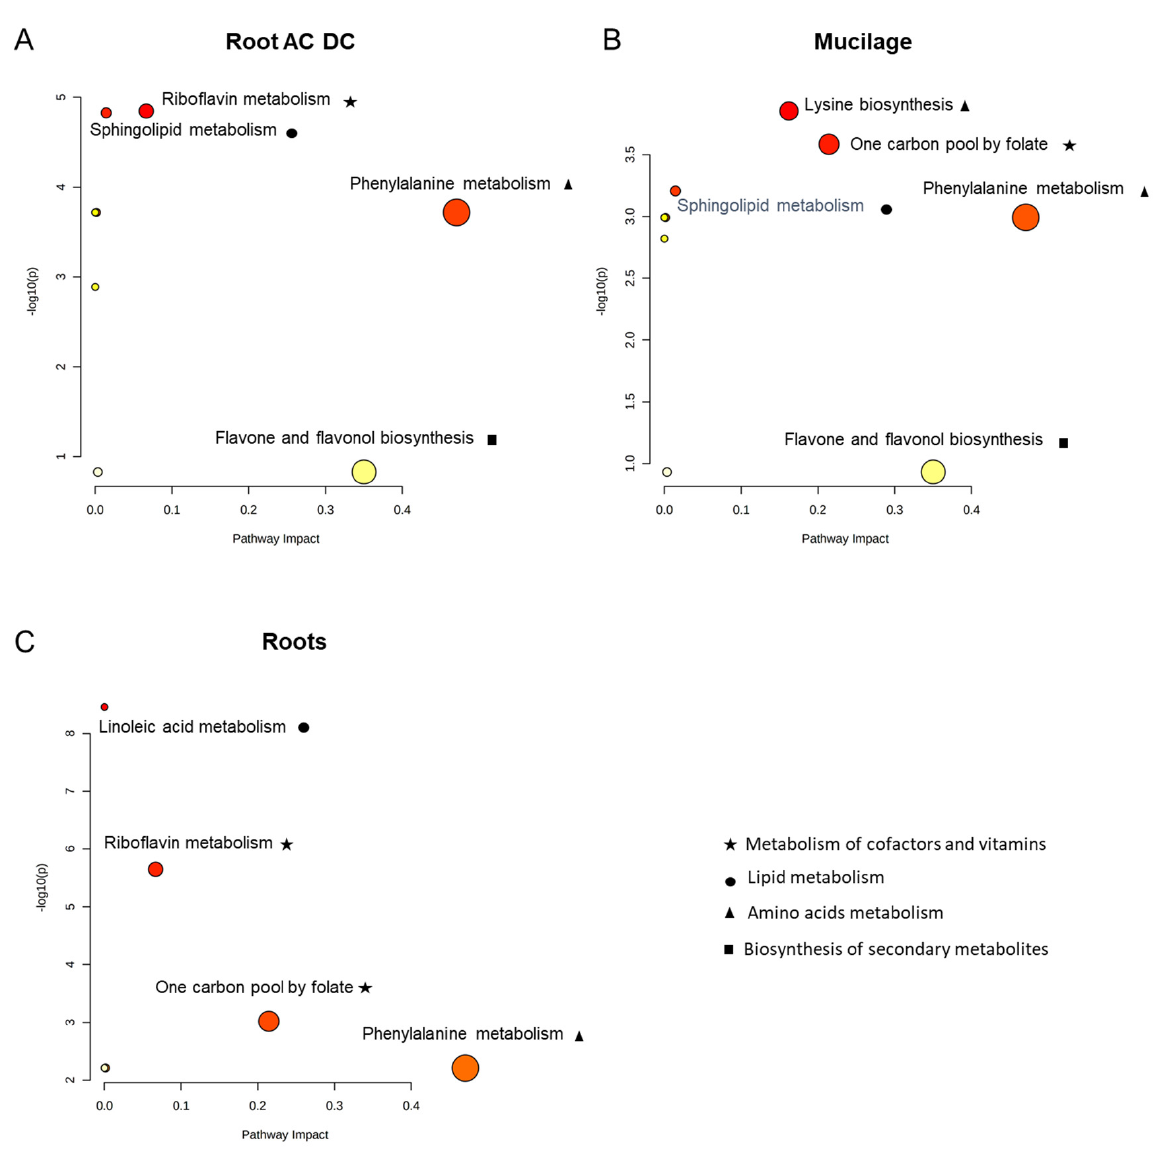
Figure 5. Pathway analysis of root, root AC-DC and mucilage upon induced defense response with PEP-13. In root AC-DC ( A ), mucilage ( B ) and roots ( C ), pathways are represented according to their impact value (pathway impact) and their p -value ( − log10( p )). Pathways with impact value > 0.1 and − log10( p ) > 1.3 are considered to be